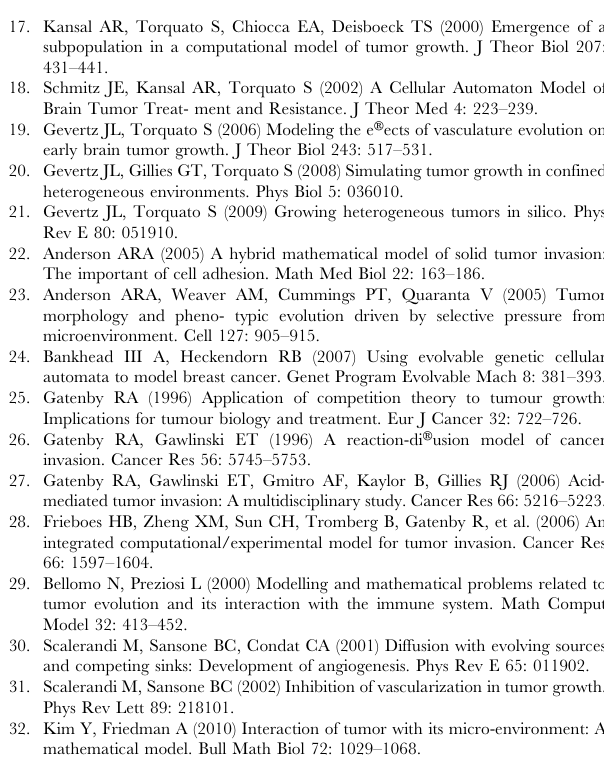
Figure S3 Evolution of a simulated invasive tumor with cellular motility m ~ 2 in a homogeneous ECM. The mutation rate is c ~ 0 : 05 and ECM degradation ability is x ~ 0 : 9 . (a) Growing tumor on day 50. (b) Growing tumor on day 80. (c) Growing tumor on day 100. (d) Growing tumor on day 120. Note that the tumor morphology on day 100 is shown in Figure 5(c) of the main paper. (TIF) Figure S4 Evolution of a simulated invasive tumor with cellular motility m ~ 3 in a homogeneous ECM. The mutation rate is c ~ 0 : 05 and ECM degradation ability is x ~ 0 : 9 . (a) Growing tumor on day 50. (b) Growing tumor on day 80. (c) Growing tumor on day 100. (d) Growing tumor on day 120. Note that the tumor morphology on day 100 is shown in Figure 5(d) of the main paper. (TIF) Figure S5 The scaled volume V T = V 0 of the primary tumors as function of time t . The volume of the tumor V T is scaled with respect to the volume of the growth-permitting region V 0 . Note that invasive cells with small motility m ~ 1 significantly enhance the growth of the primary tumor. For invasive cells with intermediate ( m ~ 2 ) and large ( m ~ 3 ) motility values, since such invaisve cells leave the primary tumor and do not contribute to the tumor volume, the size of primary tumors are smaller than the non-invasive case in early growth stages. In later stages, the invasive cells have degraded a signficant amount of extracellular matrix, leading to faster growth of the primary tumor than the non-invasive case. The final size of the tumor is determined by the volume of the growth-permitting regions. For invasive cases, at later growth stages, many invasive cells clump at the bounary of the growth-permitting region, which do not contribute to the